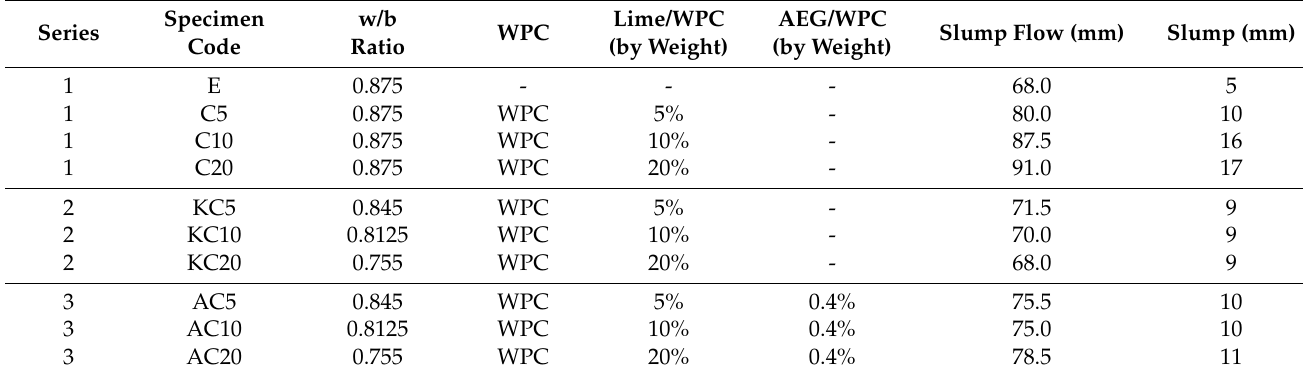
Table 1. Mortar mixtures and properties of fresh